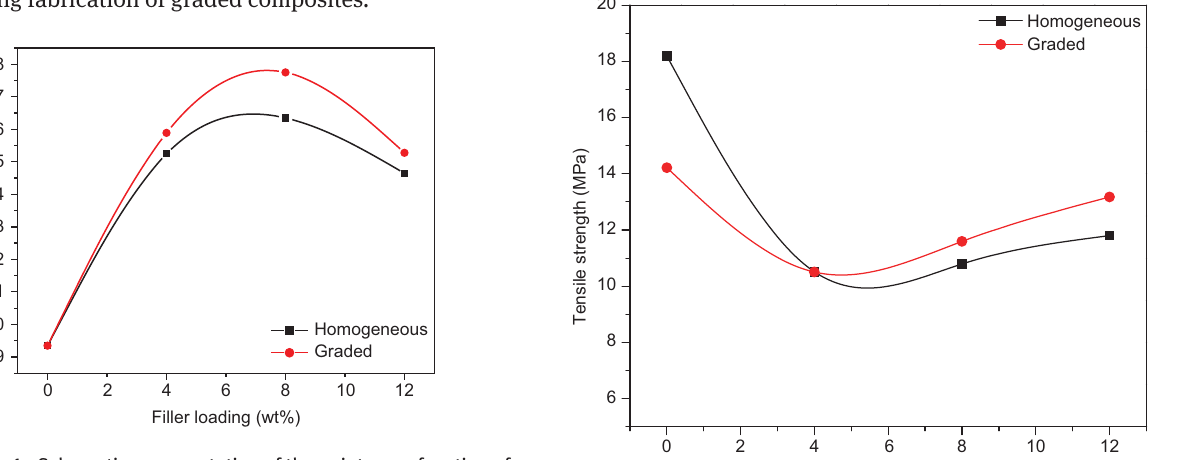
Figure 1 Schematic representation of the points as a function of distance from the geometrical center of the sample: HC ( r = 0 mm), HB ( r = 1.0 mm), HD ( r = 1.0 mm), HA ( r = 3.0 mm), HE ( r = 3.0 mm). Figure 2 Variation of tensile strength on filler loading of